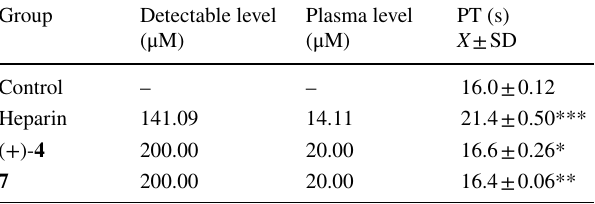
Table 6 Inhibitory effects of the isolates on PT (n = 3)